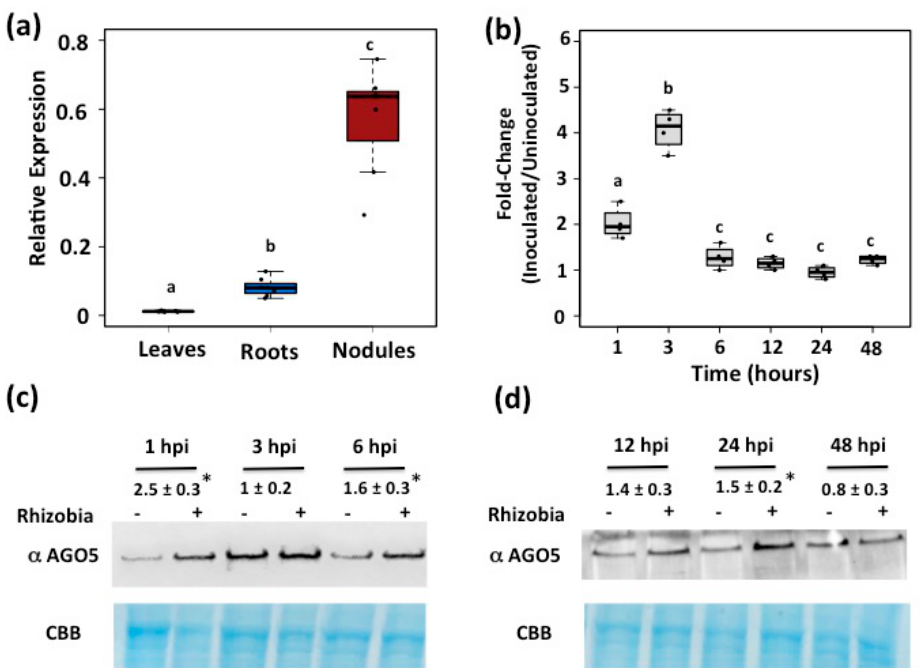
Figure 1. AGO5 from P. vulgaris ( PvAGO5 ) is preferentially expressed in root and nodules. ( a ) Expression pattern of PvAGO5 in leaves, roots and nodules from three weeks old common bean plants; ( b ) Expression profile of PvAGO5 in rhizobia-inoculated roots from two days old common bean plants. Box plots represent first and third quartile (horizontal box sides), minimum and maximum (outside whiskers). Data shown was obtained from four independent biological replicates. One-way ANOVA followed by a Tukey Honest Significant difference (HSD) test was performed ( p -value < 0.01). Statistical classes sharing a letter are not significantly different. ( c , d ) AGO5 protein expression in rhizobia-inoculated roots from two days old common bean plants. Immunoblot shown is a representative figure from three biological replicates. The intensity of the bands was quantified densitometrically, and the inoculated/un-inoculated expression ratios were obtained for each time point. Values are mean and standard error of three biological replicates. Asterisks indicate a significant difference according to Student’s t -test ( p -value < 0.01). hpi = hours post-infection.